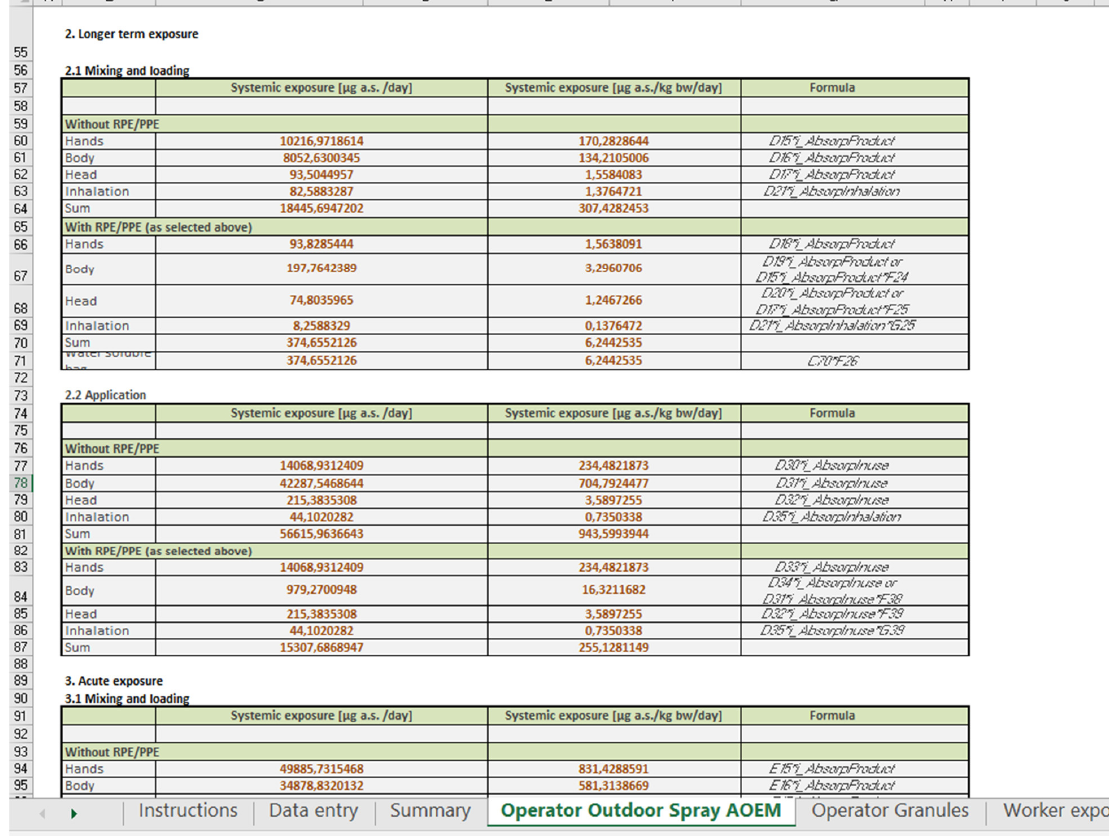
Figure A4. Linear regression of daily exposure (mg): calculated using the AOEM and measured in the CANEPA study.